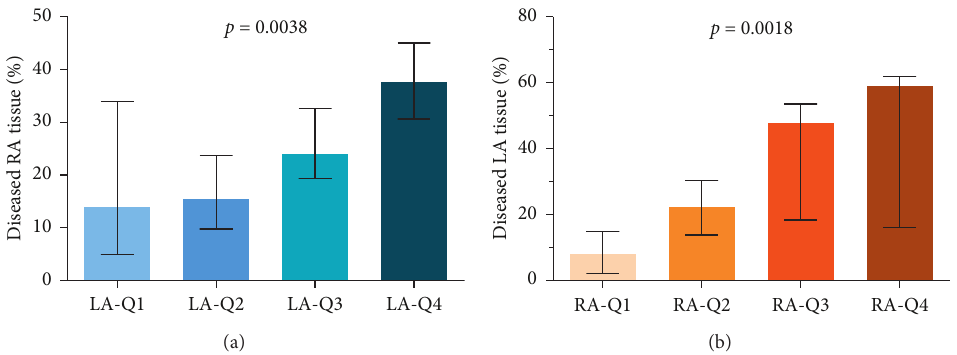
Figure 2: Comparison of left atrial (LA) and right atrial (RA) diseased tissue burden (Kruskal–Wallis test, the error bars representing median and interquartile ranges;